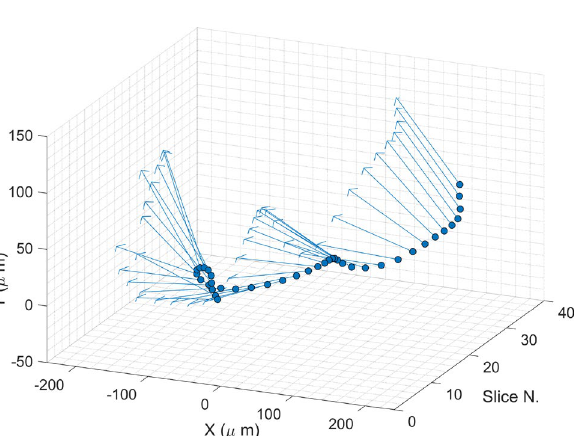
Figure 5. Three-dimensional charge density reconstruction. Reconstruction results from two different sets of experimental data. The 3D render was done with PyVista, which is a python implementation of VTK 45 . The normalization to the beam total charge value has been done after having set to 0 the voxels with negative values, constituting the halo of the figure and arising from noise of the reconstruction algorithm.